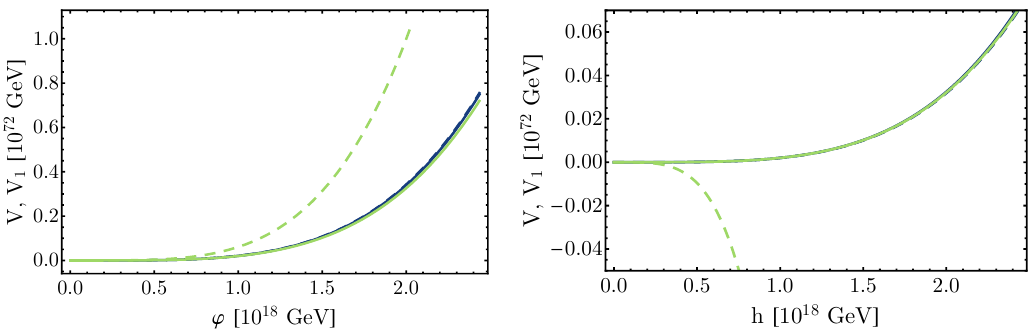
Figure 2 . The one-loop unimproved e(cid:11)ective potential V 1 (dashed lines) and the one-loop improved e(cid:11)ective potential V (solid lines) for two values of renormalisation scale (cid:22) , (cid:22) = 246 GeV (green) and (cid:22) = M P (dark blue). In the left panel the value of h is (cid:12)xed to 246 GeV and the potentials are plotted as functions of ’ . In the right panel ’ = 600 GeV and the potentials are plotted along the h direction. Note that three of the curves overlap, that is why it is hard to see the dark blue